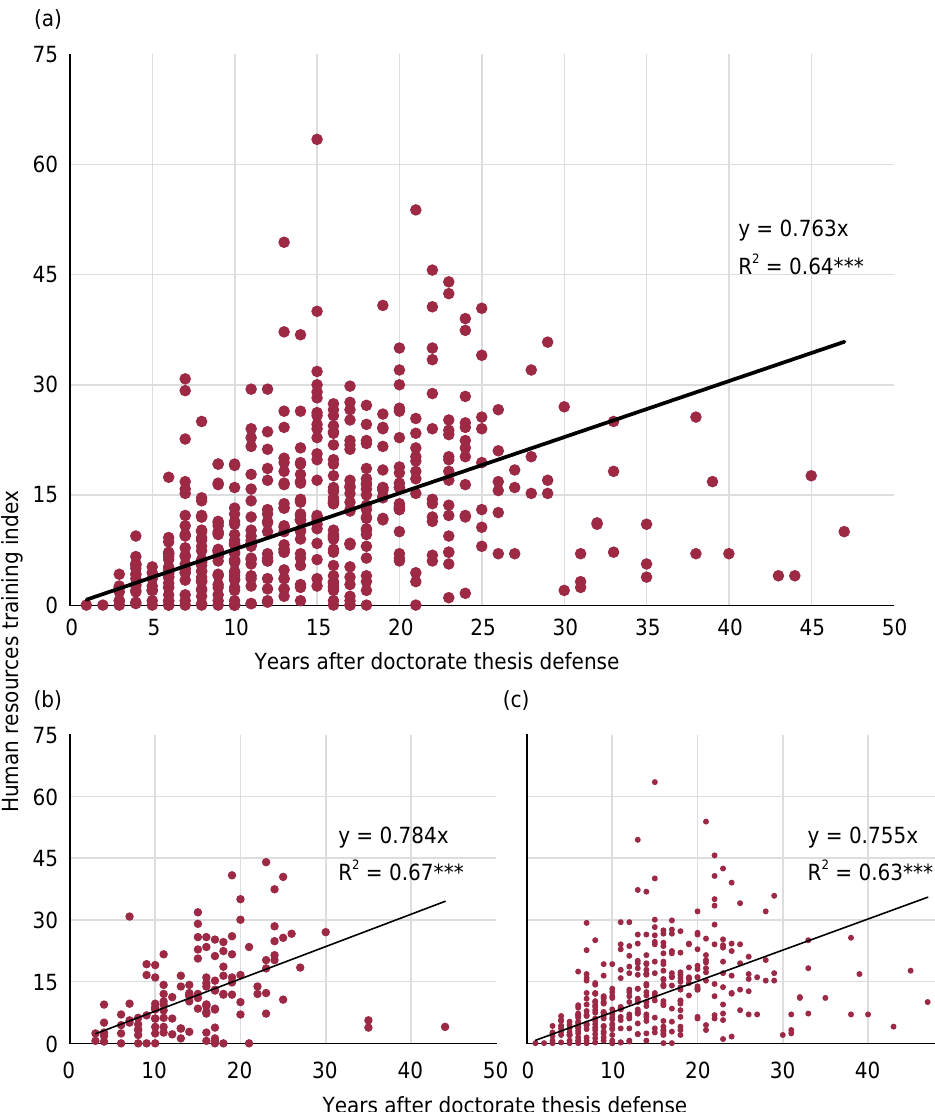
Figure 9. Human resources training index in the last five years (January 2013 to October 2018), as a function of the number of years after the end of the doctoral course, for all researchers, regardless of gender (a) and by gender women (b ) and men (c), in CNPq Call